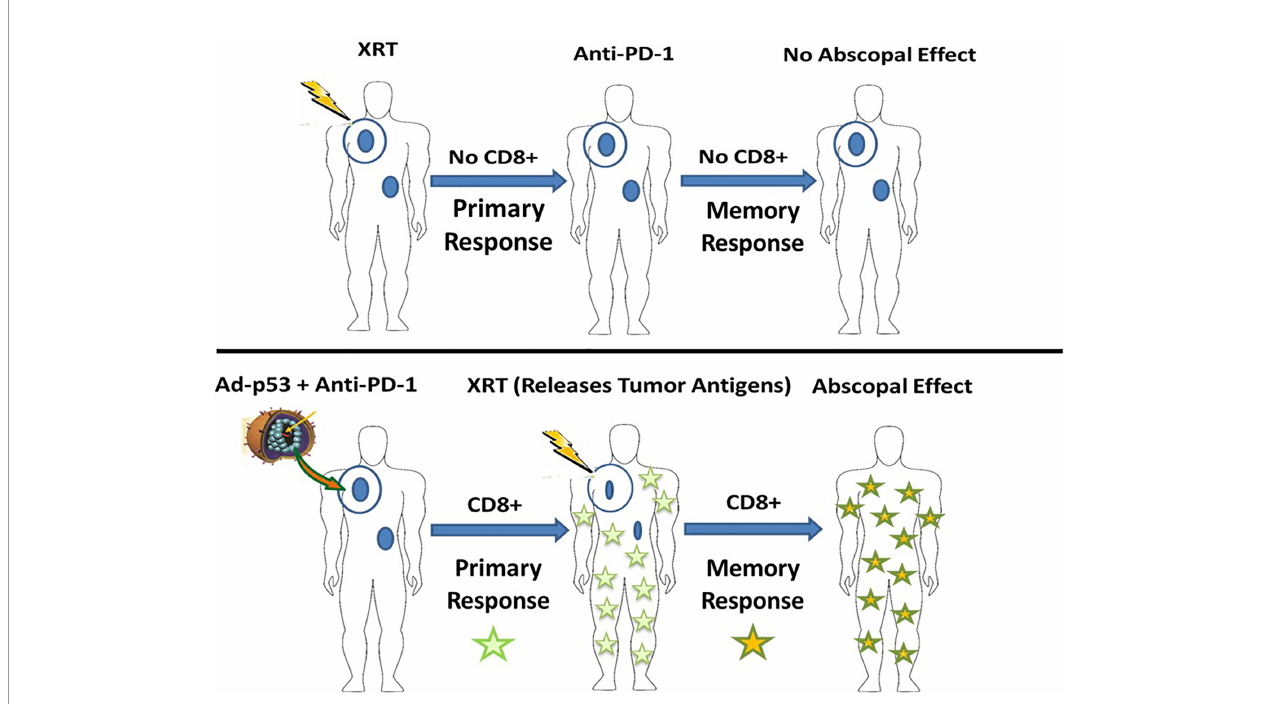
FIGURE 5 | Hypothesis of the abscopal effect as a secondary, memory CD8+ T cell response triggered by antigen release of localized therapy in patients with prior induction of primary anti-tumor CD8+ T cell